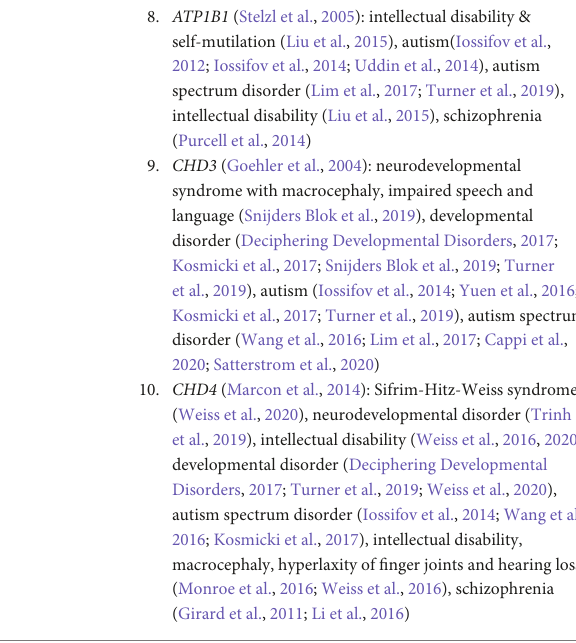
Table 1 ). Disease Gene Network Analysis (DisGeNET 6 , version 7.0) and HPO (Human Phenotype Ontology 7 , version 1.7.16) provided additional substantiation of the candidacy of our candidate genes in